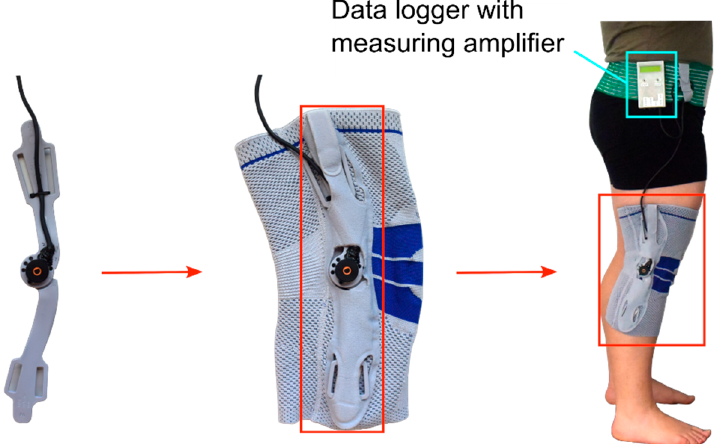
Figure 1. Implementation of the potentiometer to the lateral side of a conventional knee brace as indicated by the red arrows and boxes; the instrumented knee brace is connected to a data logger via cable as indicated by the blue box.